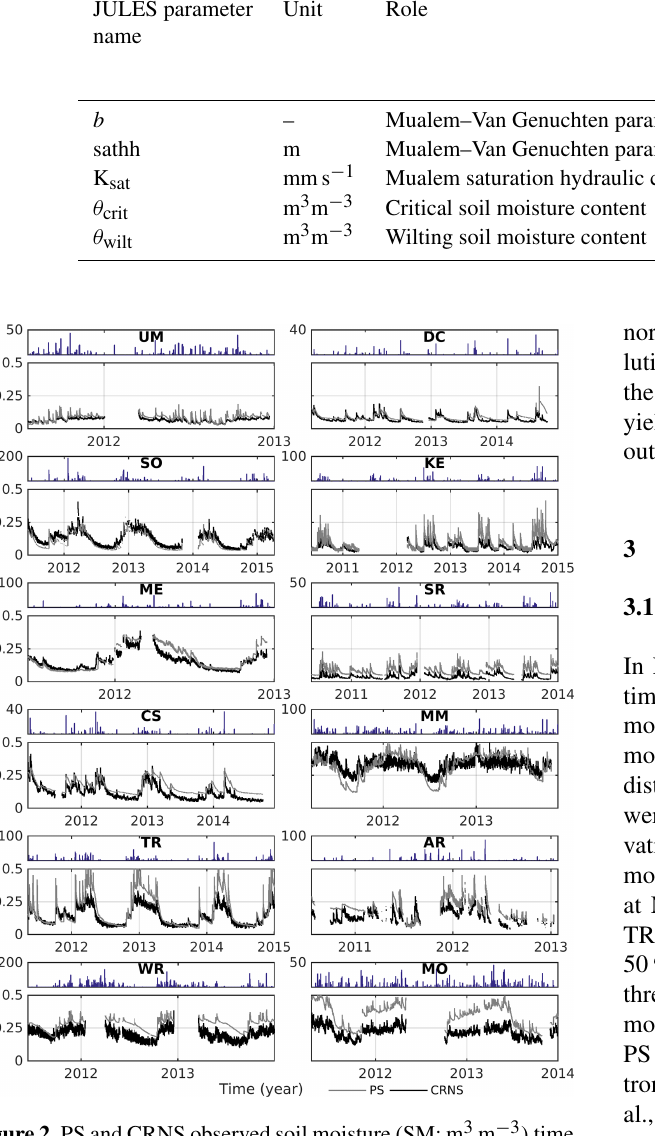
Figure 2. PS and CRNS observed soil moisture (SM; m 3 m − 3 ) time series for the 12 study sites. Notice that the PS soil moisture time series have been linearly interpolated from individual measurement depths to the corresponding JULES soil layers. CRNS soil moisture was obtained using COSMIC while assuming vertically homoge- neous soil moisture. Daily precipitation (mmday − 1 ) is also shown here for each